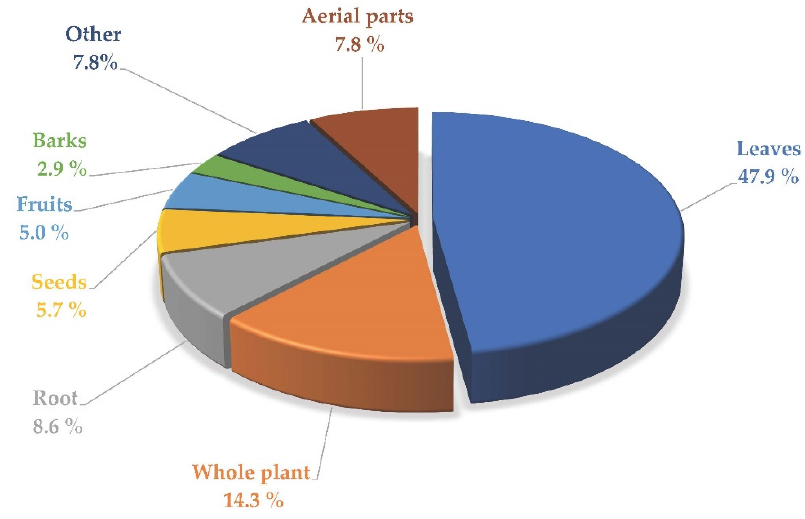
Figure 2. Part of the plant used.